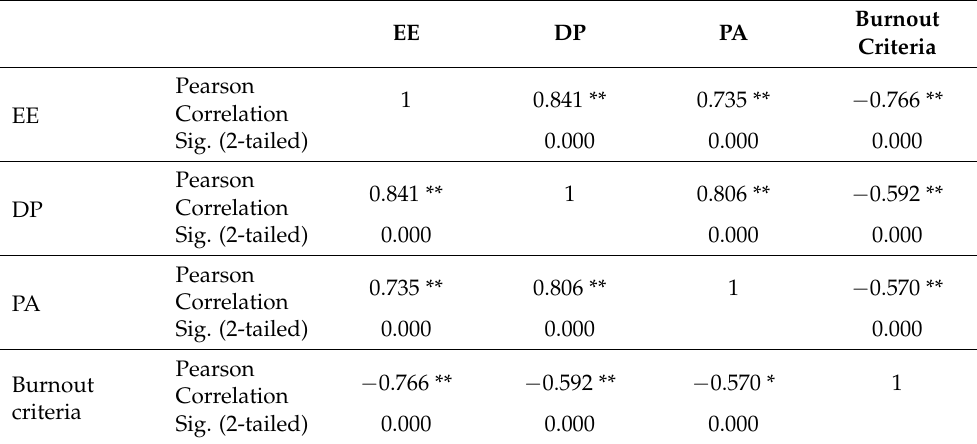
Table 3. The correlation between burnout criteria, emotional exhaustion, depersonalization and personal